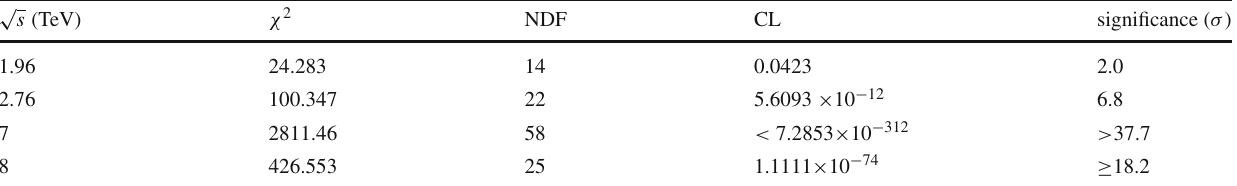
Table 1 Summary on Odderon signal observation significances in the ReBB model analysis. The significances higher than 8 σ were calculated by utilizing an analytical approximation schema, detailed in Appendix A √ s (TeV) χ 2 CL